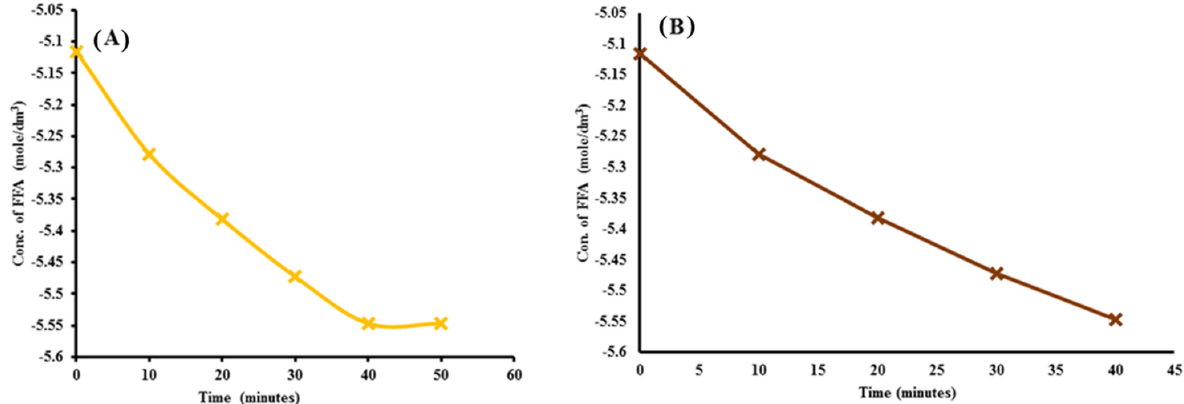
Figure 6. Graph showing progress of the esterification reaction at a constant temperature (55 °C). ( A ) Linear portion of the graph, showing the progress of the reaction, used to calculate the rate of the esterification reaction at a constant temperature (55 °C) ( B ).